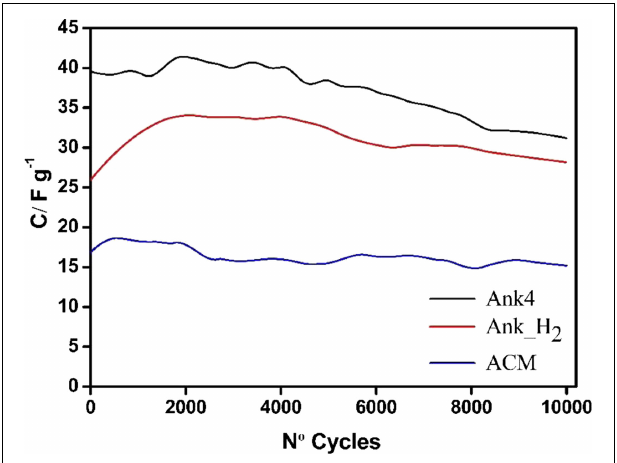
FIGURE 12 | Steady voltammograms of supercapacitor based on Ank4 for a voltage of 1.8V ( υυυ = 5mVs (cid:0) 1 ; 0.5M Na 2 SO 4 ) .